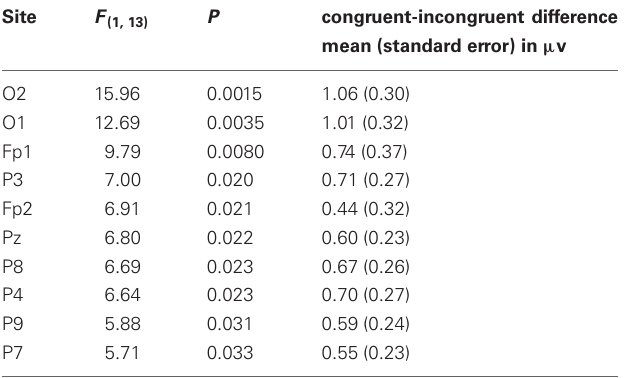
congruent-incongruent amplitude differences in the early, 92–240ms latency interval, for those electrode sites that displayed a significant congruency effect in the early